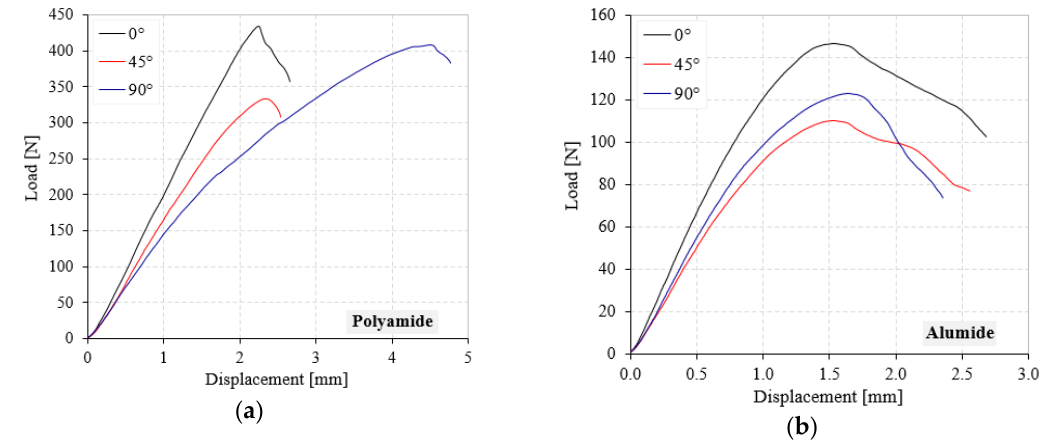
Figure 6. Load-displacement curves of polyamide ( a ) and Alumide ( b ) notched samples.